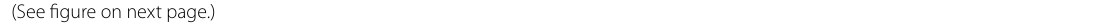
figure on next Fig. 6 LncRNA-ATB regulates the COM-induced renal injuries via miR-200a. a , b The transfection efficiencies of miR-200a mimics ( a ) and inhibitors ( b ) were validated by qRT ‐ PCR. c The cell damage was assessed by a Cytotoxicity LDH Assay Kit. d , e The expression levels of KIM-1 were detected by western blot analysis. f The expression levels of KIM-1 were detected by immunofluorescence. g Cell proliferation was assayed by CCK-8. h – k Cell apoptosis measured by flow cytometry h , i and TUNEL staining ( j , k ). All above the experiments were repeated 3 times, values are mean